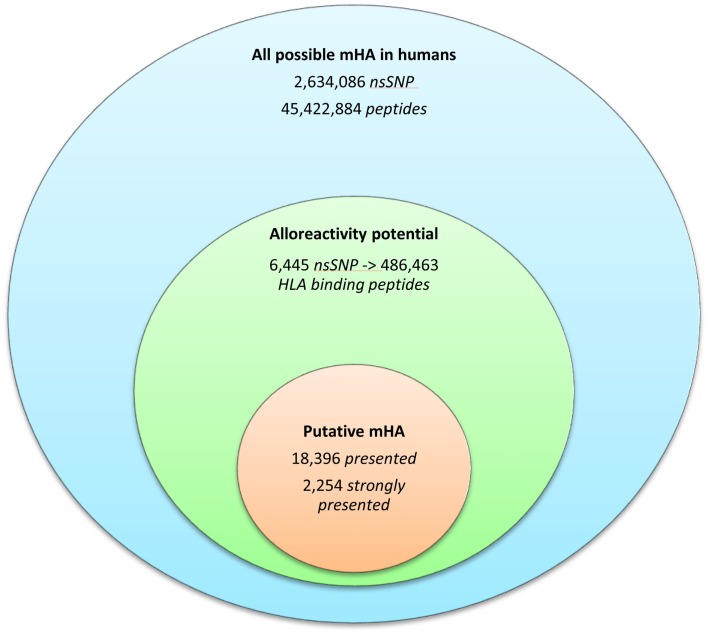
The burden of minor histoincompatibility in human SCT. (A) All possible mHA in human beings: data generated from NCBI dbSNP database (22). (B) Alloreactivity potential: the current patient cohort had an average of 6,445 nsSNPs/DRP, which when converted into peptide fragments averaged 486,463 possible mHA/DRP. (C) Putative mHA: each DRP had its nsSNPGVH-encoded peptides filtered by predicted binding to six HLA class I alleles specific to that DRP. Average number of peptides with binding affinity labeled presented (<500 nM), and strongly presented (<50 nM) is shown.